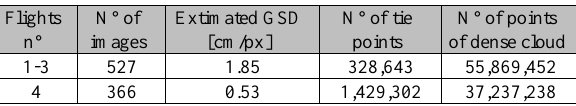
Table 8. Main details of the photogrammetric process.